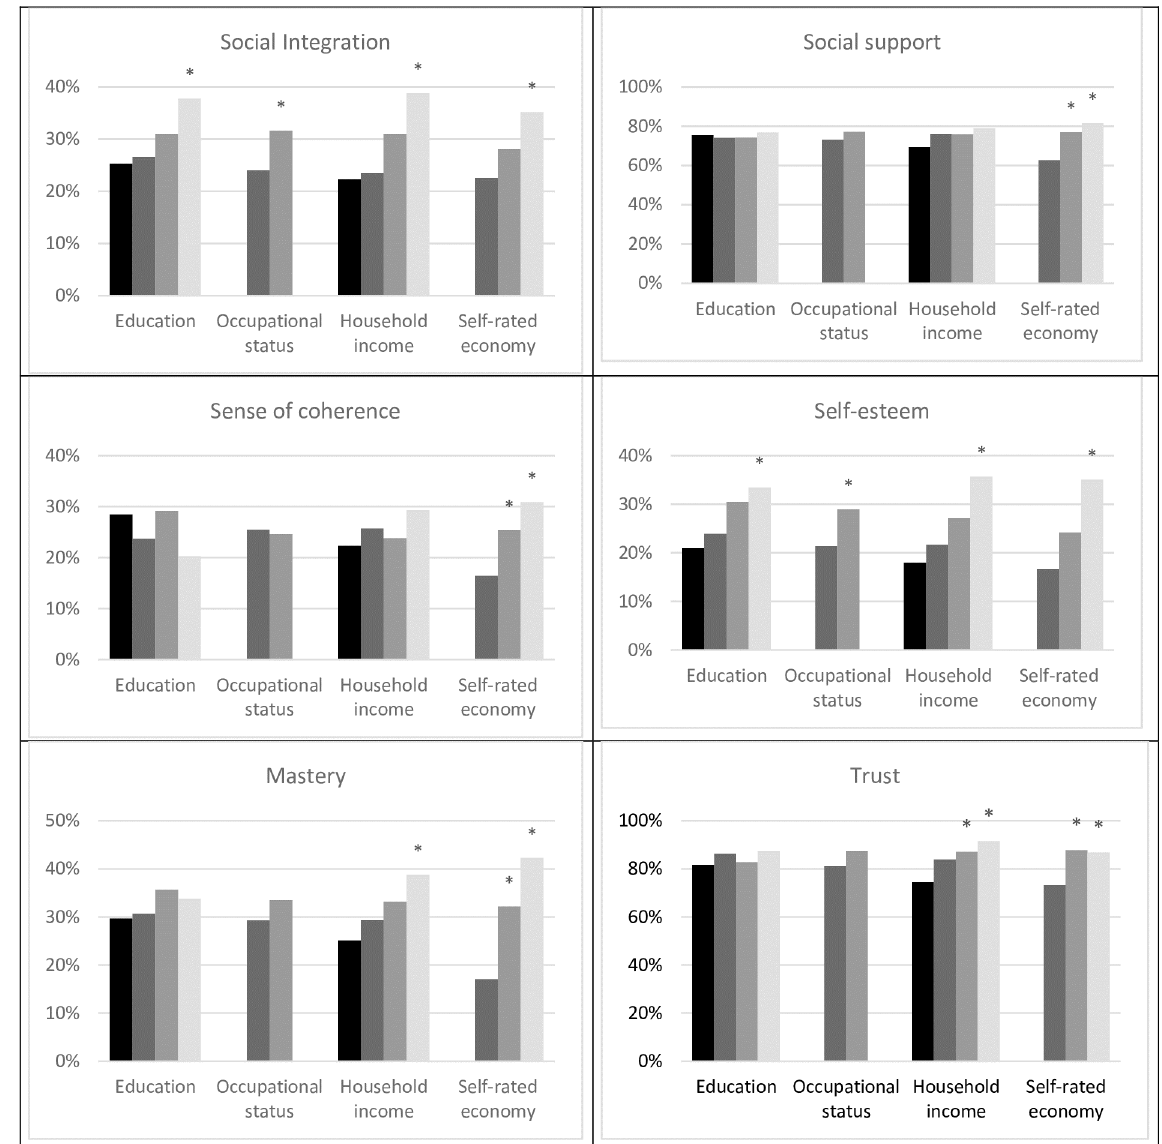
Fig 1. Prevalence of participants with high scale scores of psychosocial resources, stratified on SES measurements. * Statistically significanthigherprevalencecomparedwith the lowest group within each SES